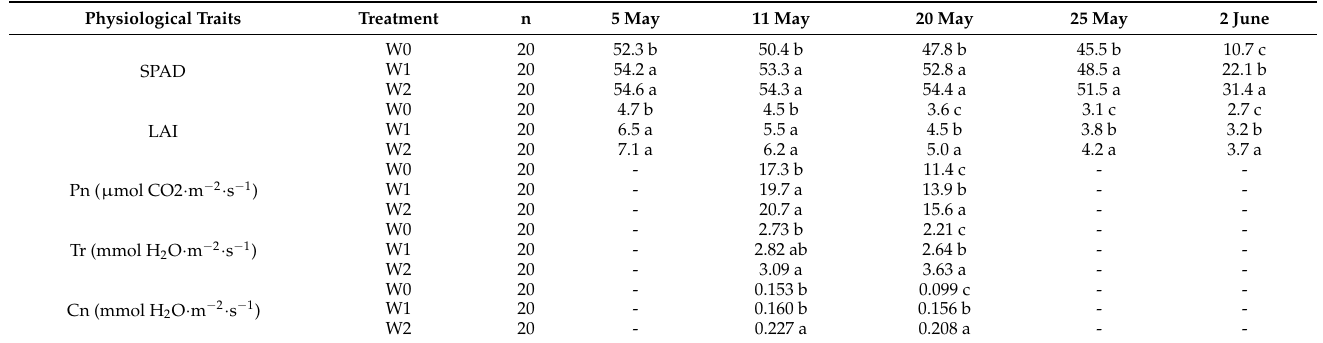
Duncan’s multiple range test was used to compare the mean values of physiological traits under different water treatments. Within each trait, any two treatments showing different letters are significantly different in the mean